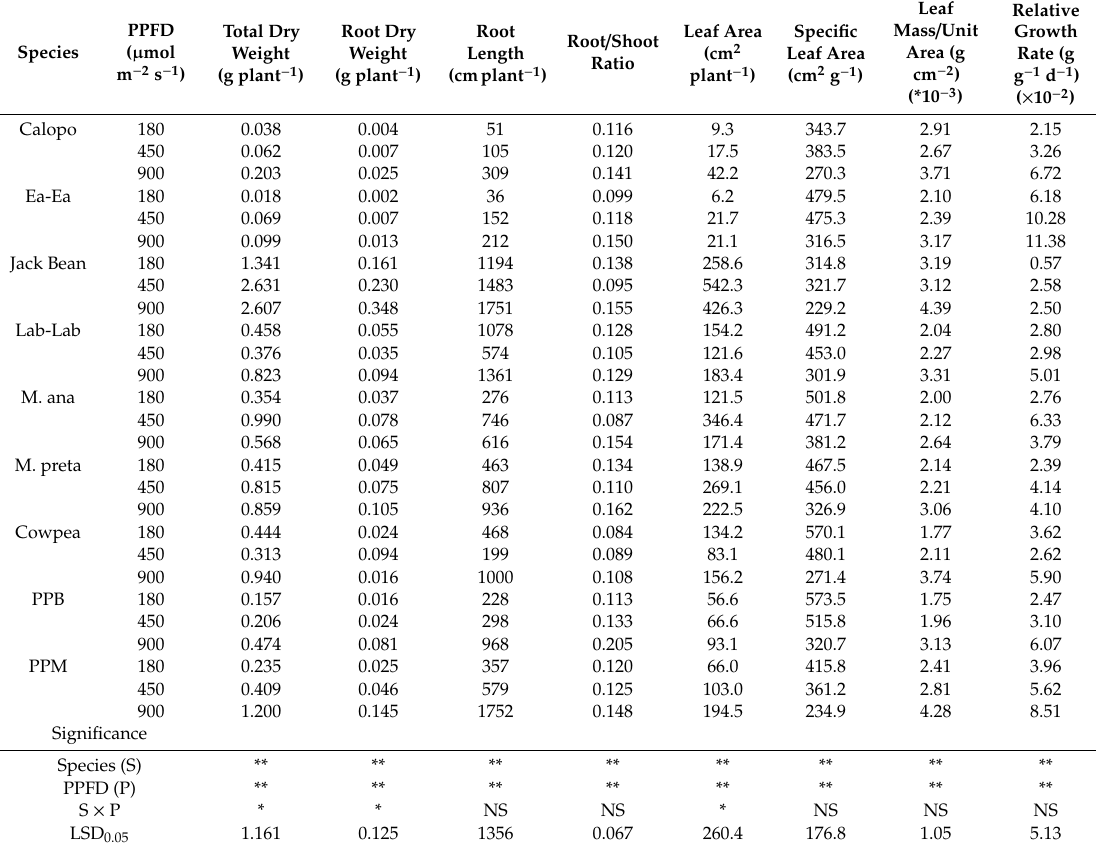
Table 2. E ff ect of photosynthetic photon flux density (PPFD) on shoot and root growth in cover crops. PPFD Species ( µ